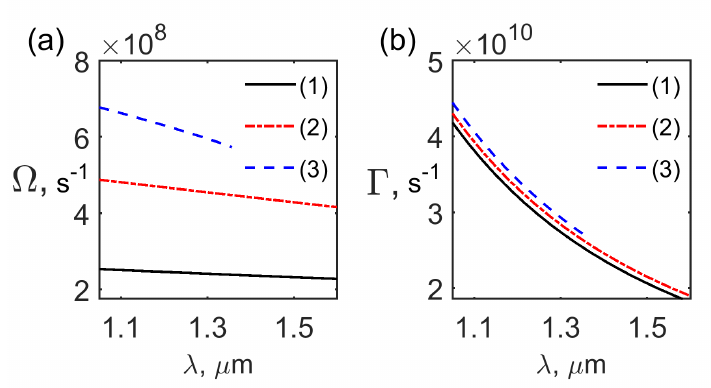
Figure 5. The SS frequency Ω ( a ) and decay constant Γ ( b ) dependence on the optical wavelength